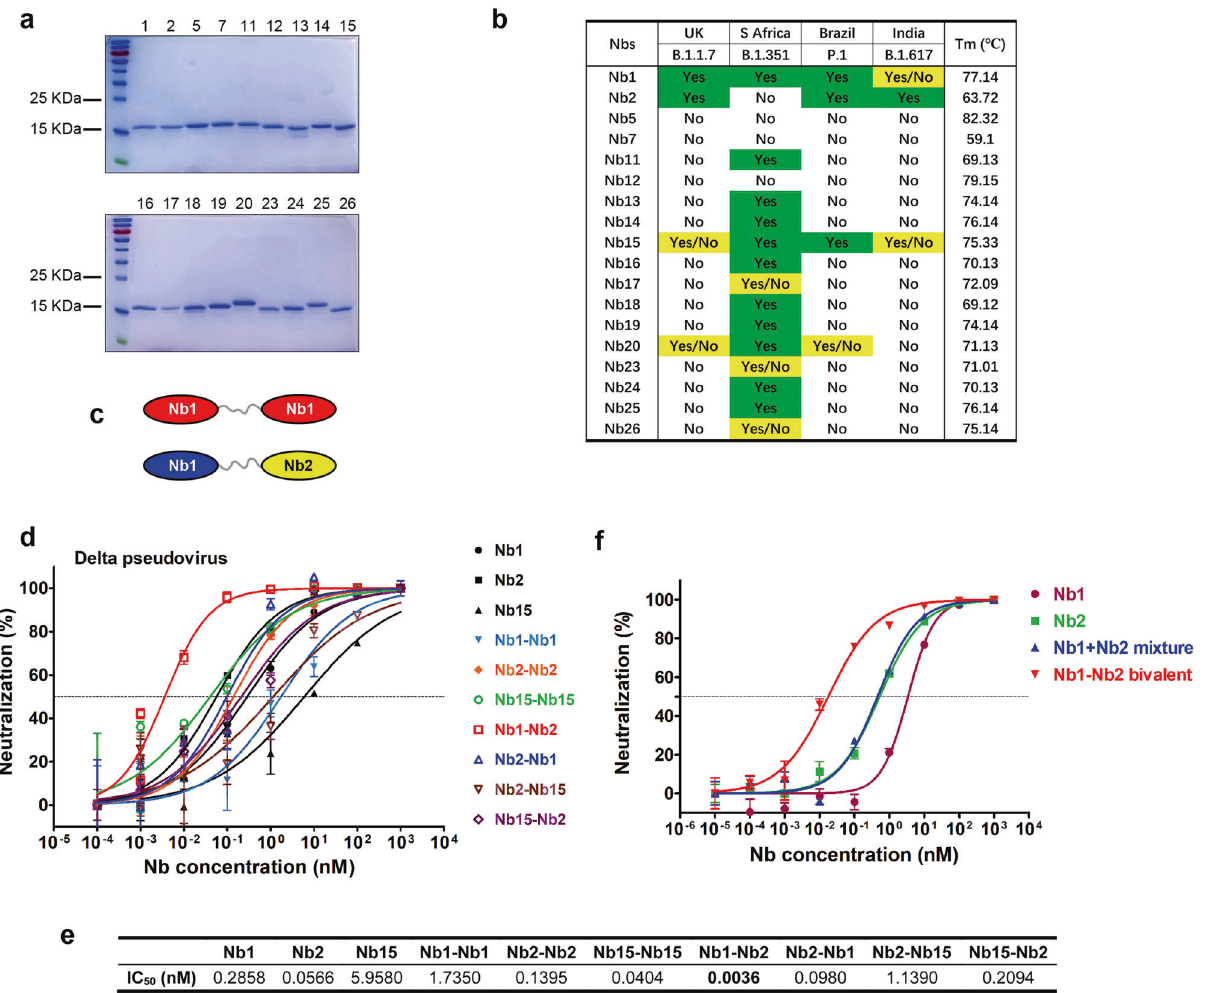
Fig. 1 Screen and design of broad-spectrum neutralizing Nbs against SARS-CoV-2. a The puri fi ed recombinant proteins of SARS-CoV-2 RBD binding Nbs were separated by SDS-PAGE and stained with Coomassie Blue. b Nbs were incubated with the indicated SARS-CoV-2 variant pseudoviruses at a fi nal concentration of 5 μ g/mL (0.33uM) and inoculated into Huh7 cells. At 48 h post infection, luciferase activities were measured, and percent neutralization was calculated. Neutralization ef fi ciency more than 90% was speci fi ed as Yes, 50 – 90% as Yes/No, and less than 50% as No. Thermal stability of the puri fi ed Nbs were measured using circular dichroism spectra. c Schematic diagram for construction of homo- or heterodimeric Nbs. d Neutralization of SARS-CoV-2 Delta variant Spike-derived pseudovirus by various bivalent Nbs. The experiments were performed independently at least twice and similar results were obtained. One representative experiment was shown, and data were average values of three replicates ( n = 3). e Summary of the half-maximal inhibitory concentration (IC 50 ) values of ( d ). f Pseudovirus neutralization activity of different Nb